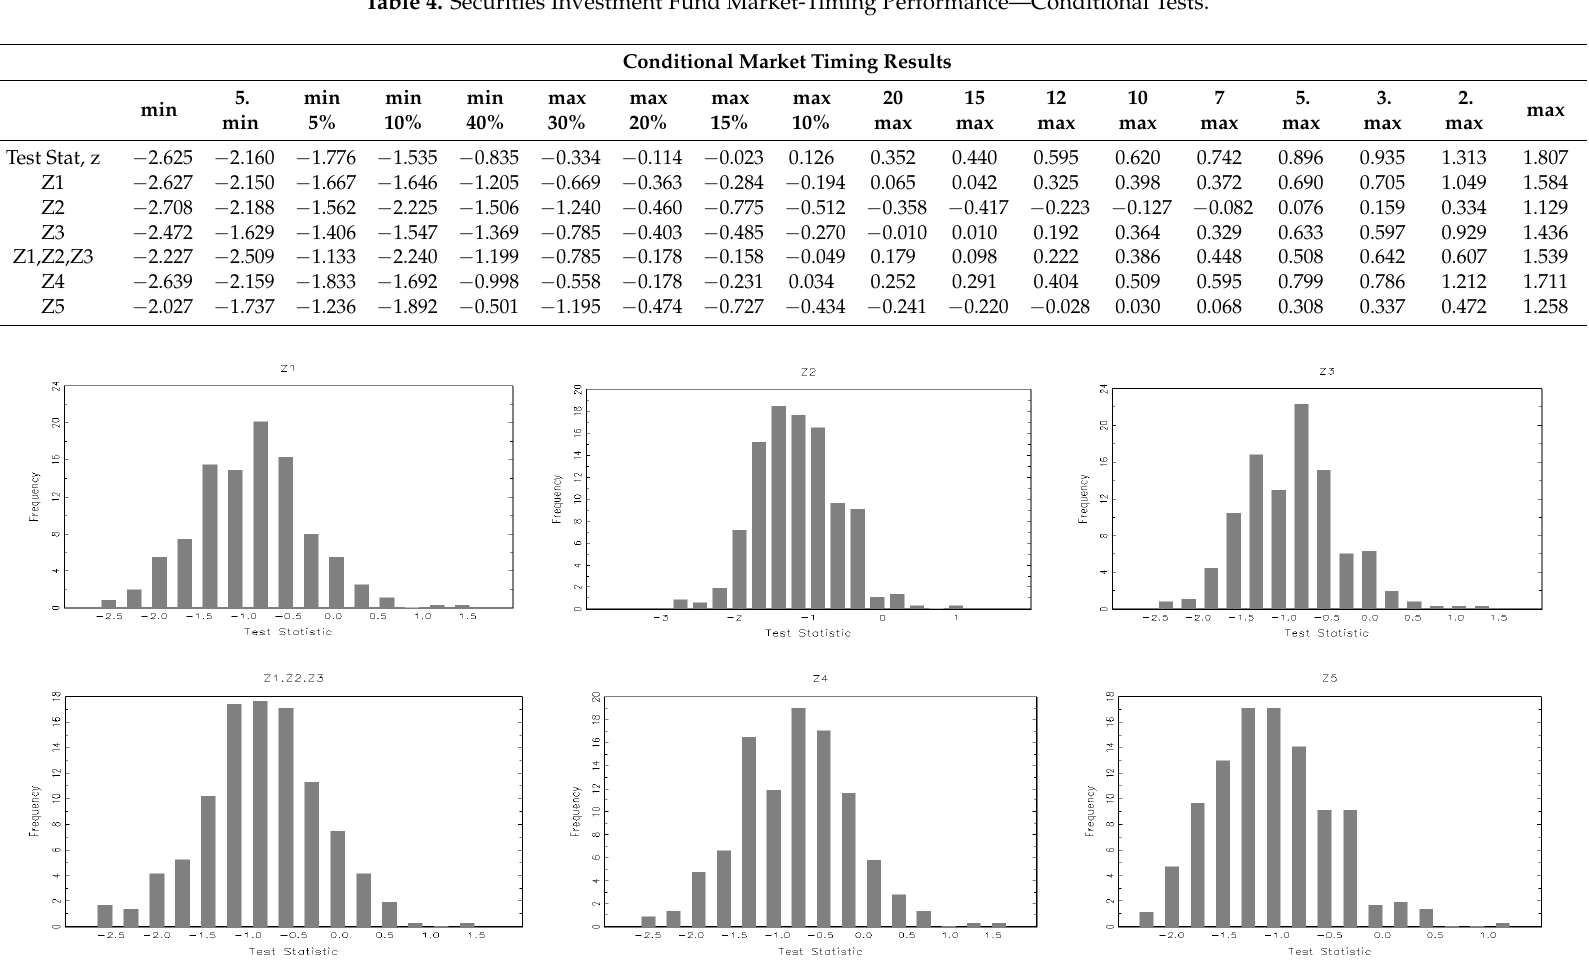
Figure 2. Distributions of Conditional Market-Timing Test Statistics.